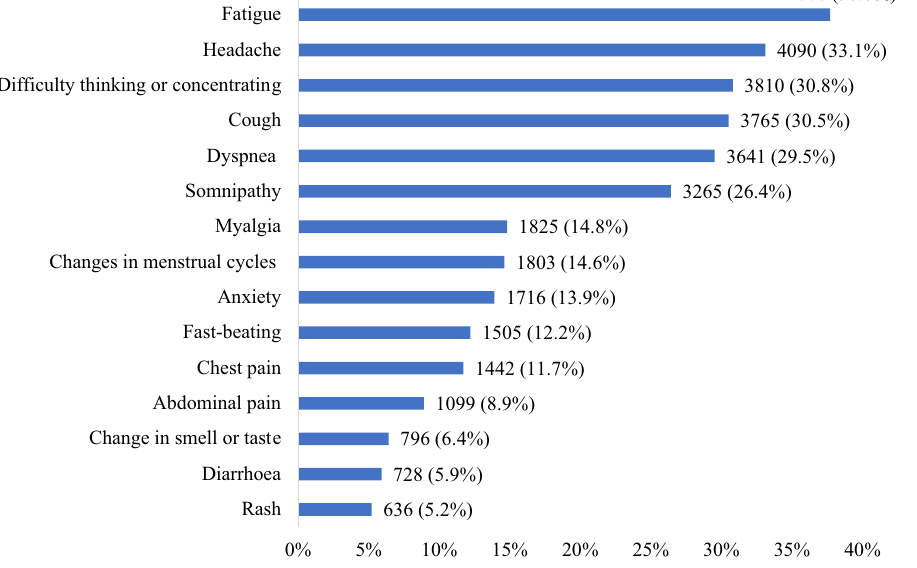
From Fig. 1, fatigue was the most common symptom of participants (37.7%), followed by headache (33.1%). Moreover, symptoms such as difficulty thinking or concentrating, cough, dyspnea, and somnipathy had a high percentage of 30.8%, 30.5%, 29.5%, and 26.4%, respectively. Table 3 revealed that neurological symptoms were the most frequent symptoms of post-COVID-19 across all regions, followed by respiratory and heart symptoms. In general, approximately one-third (31.1%) of participants